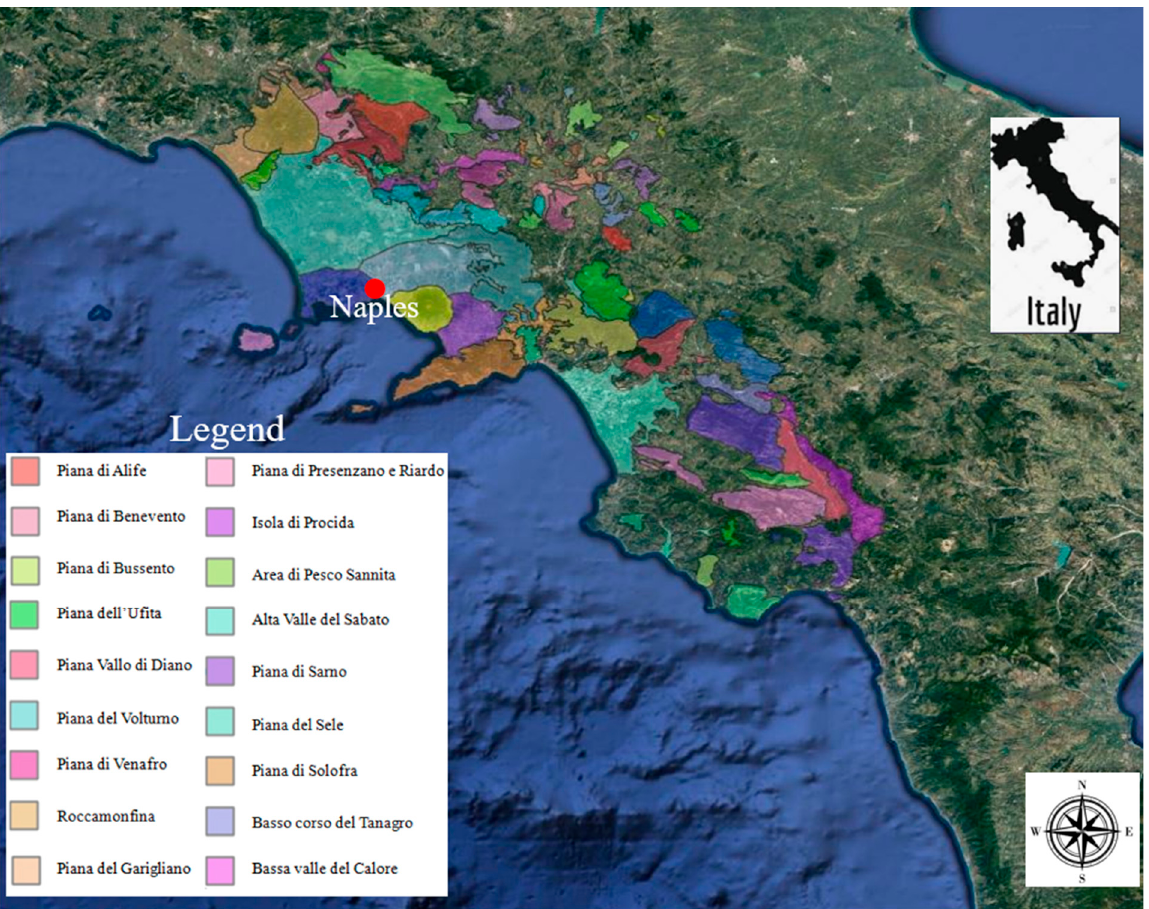
Figure 1. Map of the study area of Campania Region.